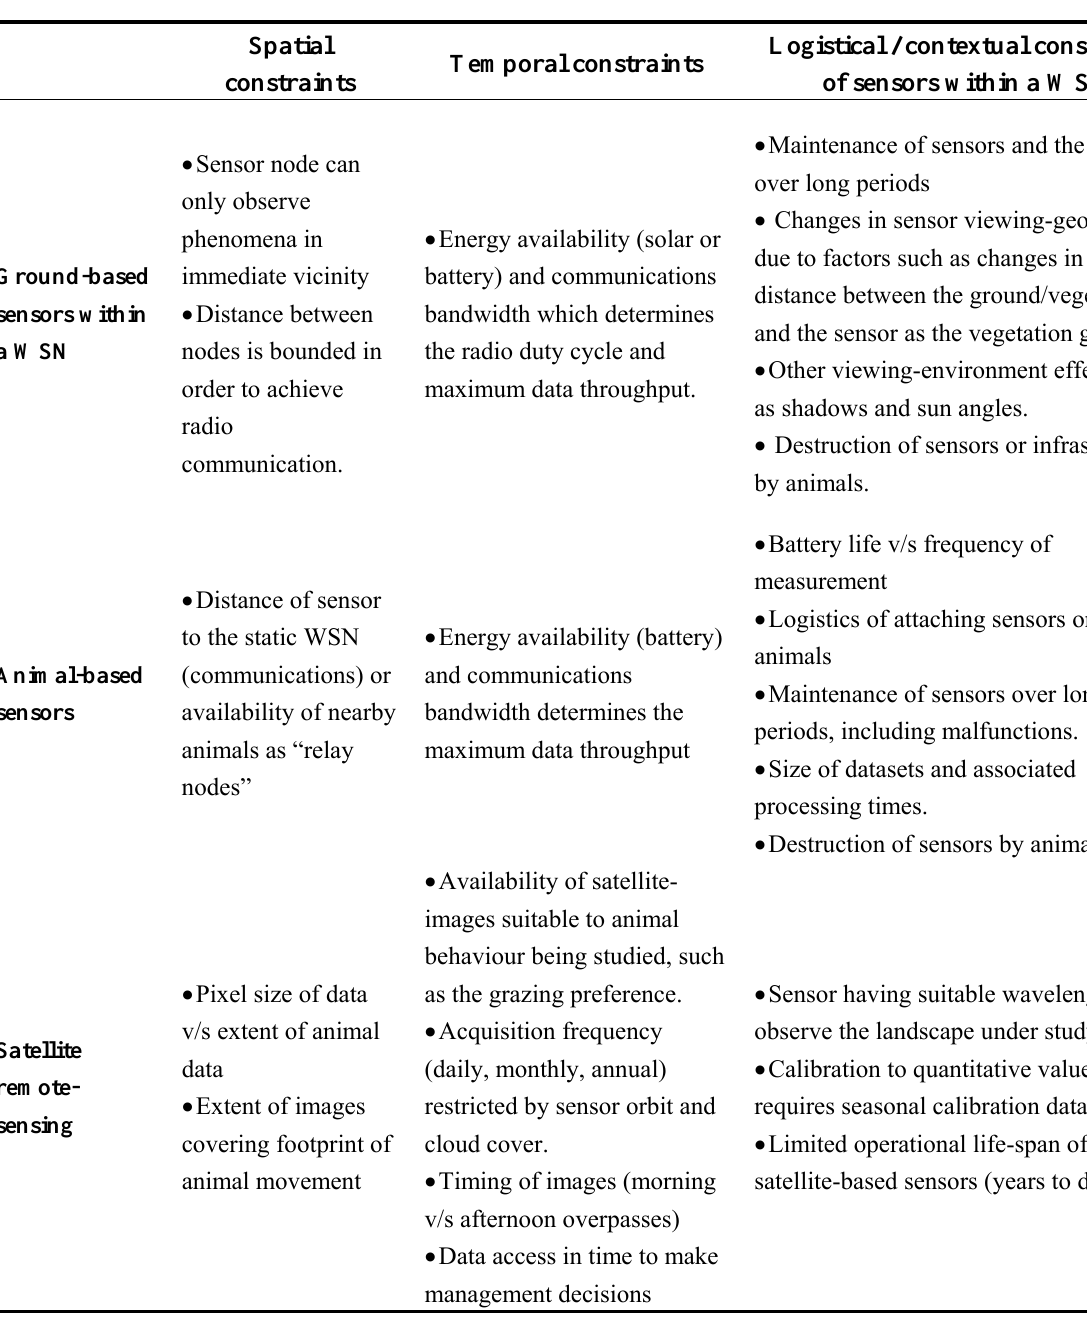
Table 1. Constraints to an integrated system of ground-, animal- and satellite-based sensors within a WSN